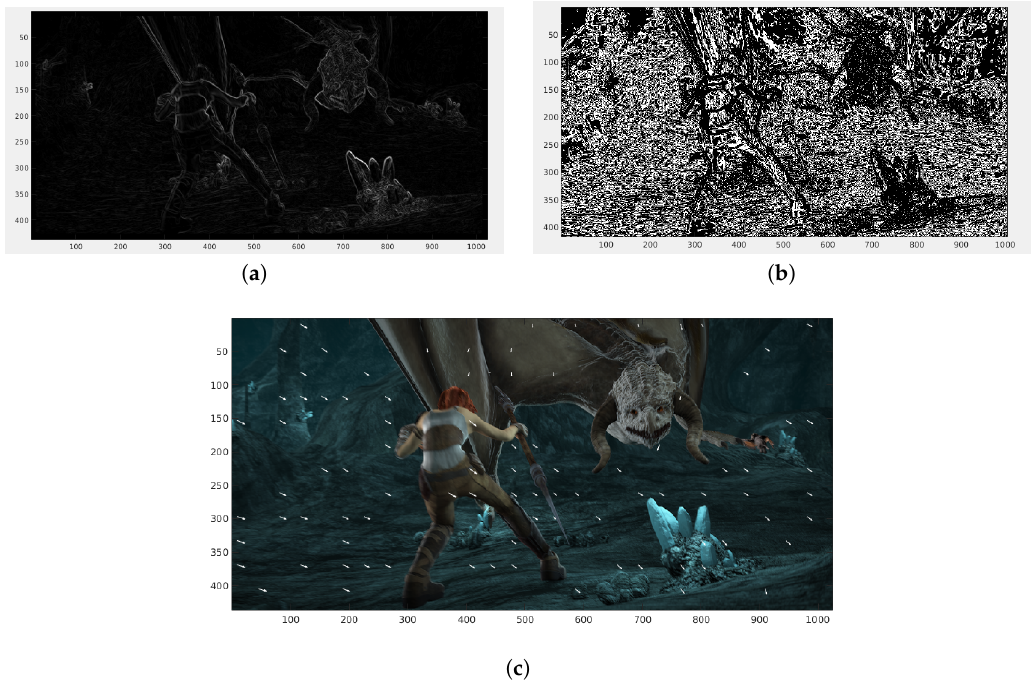
Figure 6. ( a ) Gradient of the reference image. ( b ) Medium gradient set. ( c ) Matching result of the patches located in the medium gradient uniform